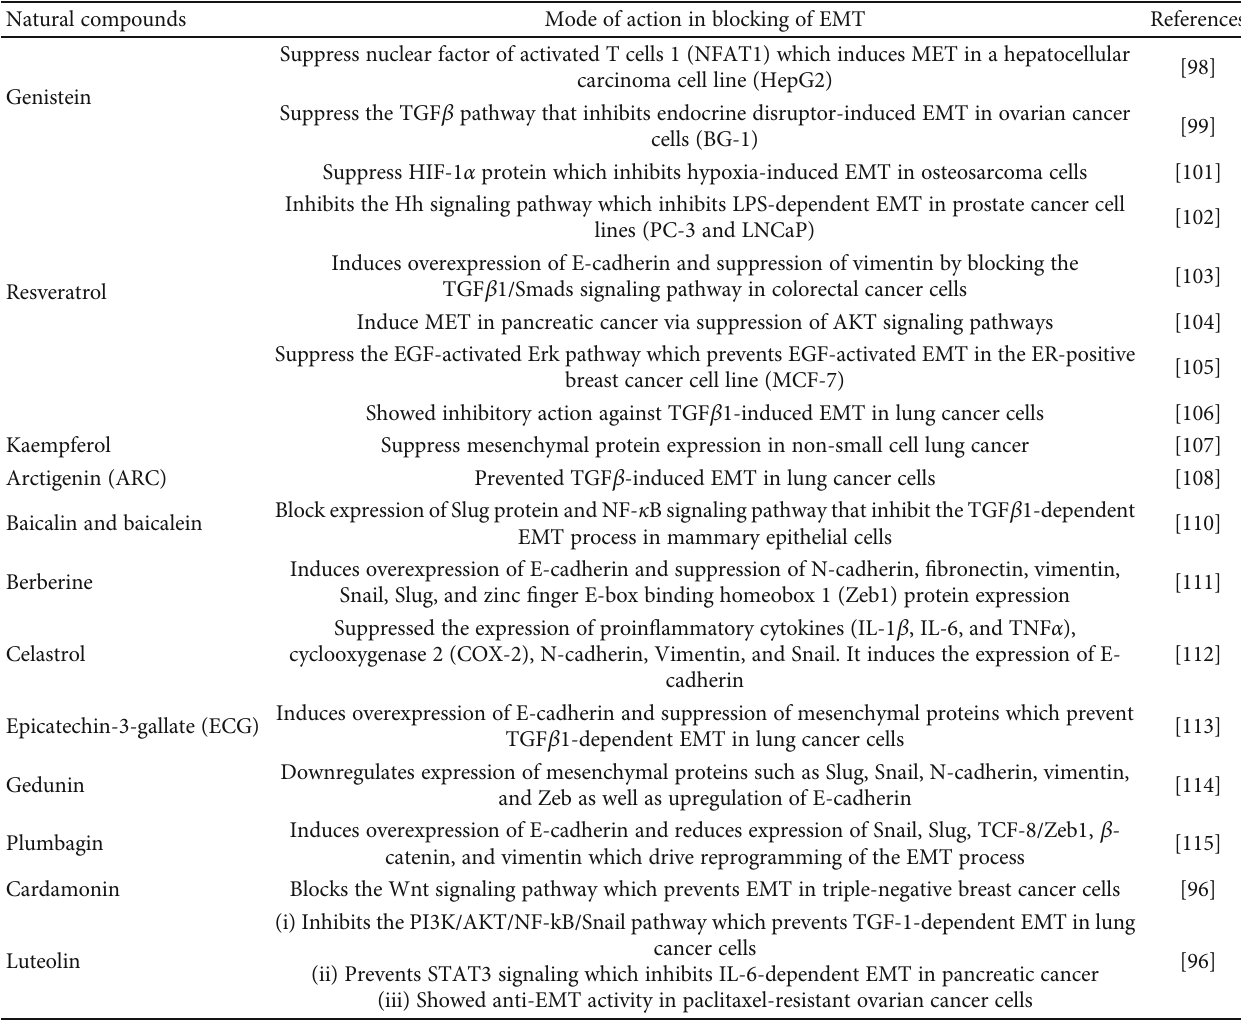
Table 2: Natural compounds involved in modulation of epithelial-to-mesenchymal transition (EMT). Natural compounds Mode of action in blocking of EMT